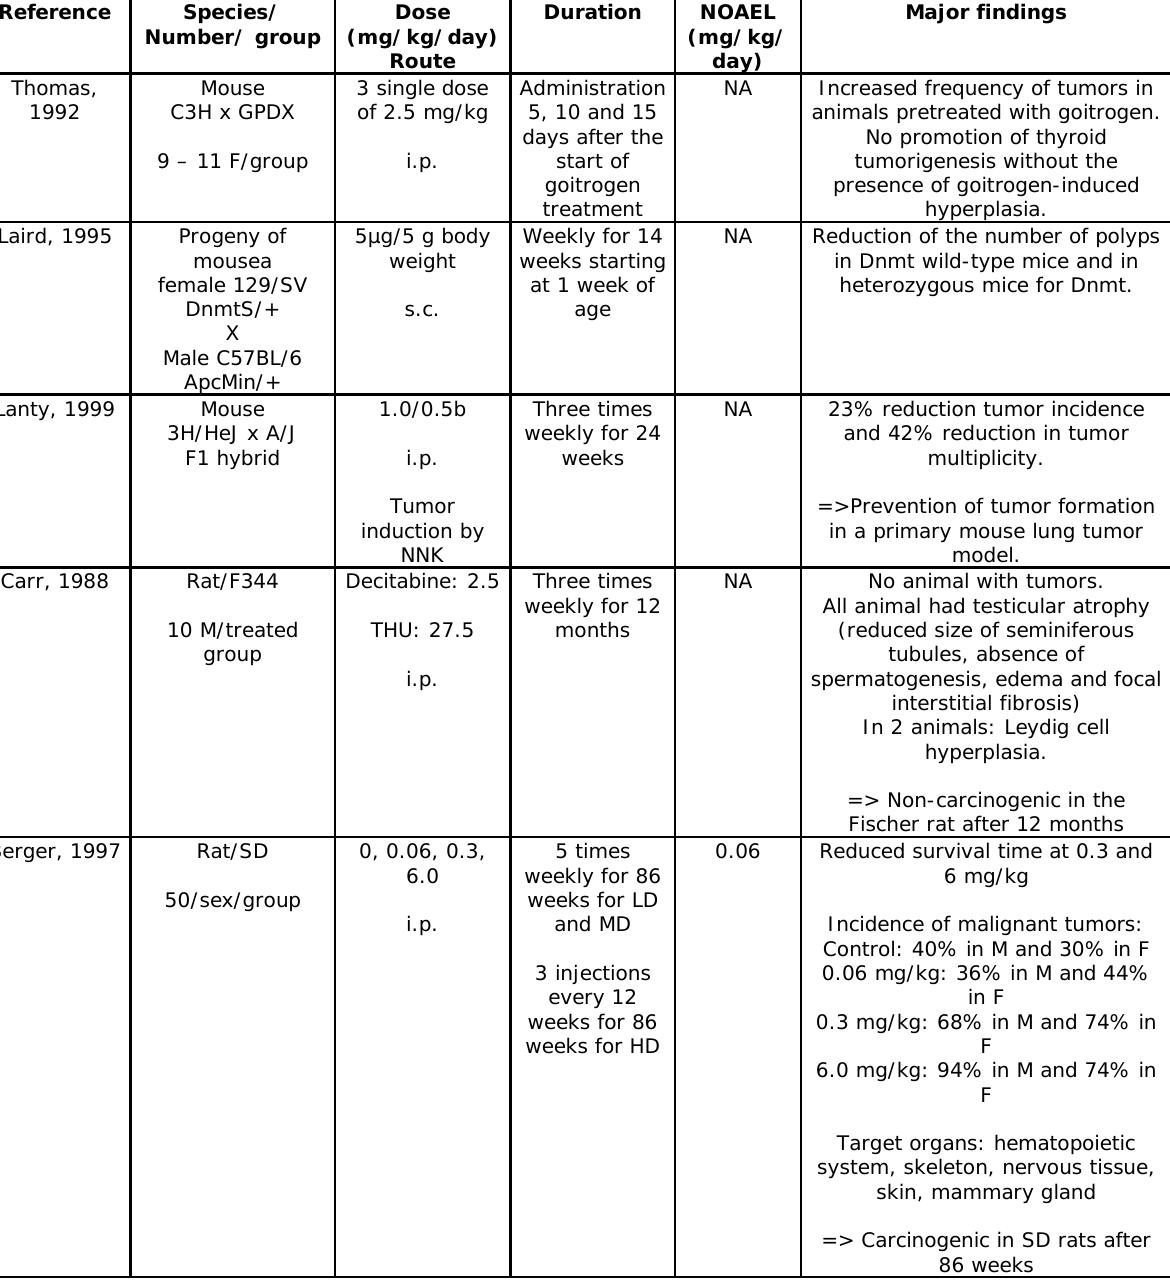
Table 8: Summary of carcinogenicity studies from literature